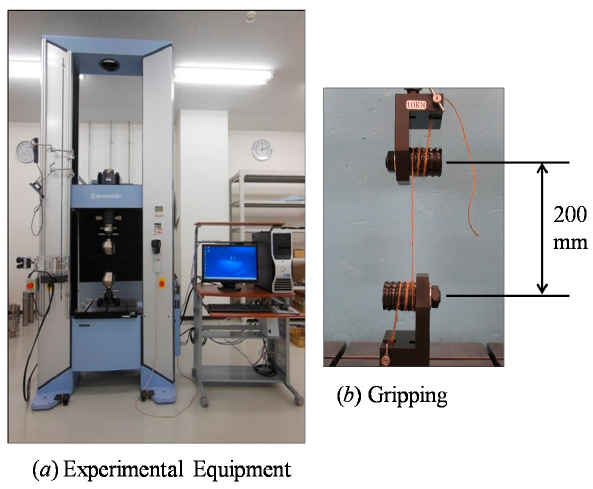
Figure 2. Experimental setup for tensile testing of jute yarn.